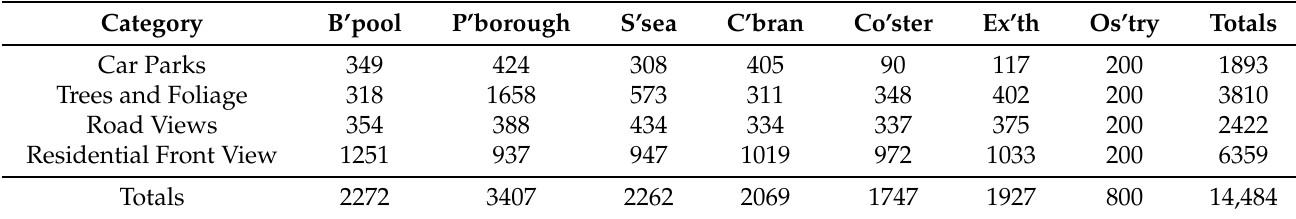
Table 2. A breakdown of the image dataset used to retrain Convolutional Neural Network (CNN) 1. The Oswestry data are used for validation and hyper-parameter optimisation.